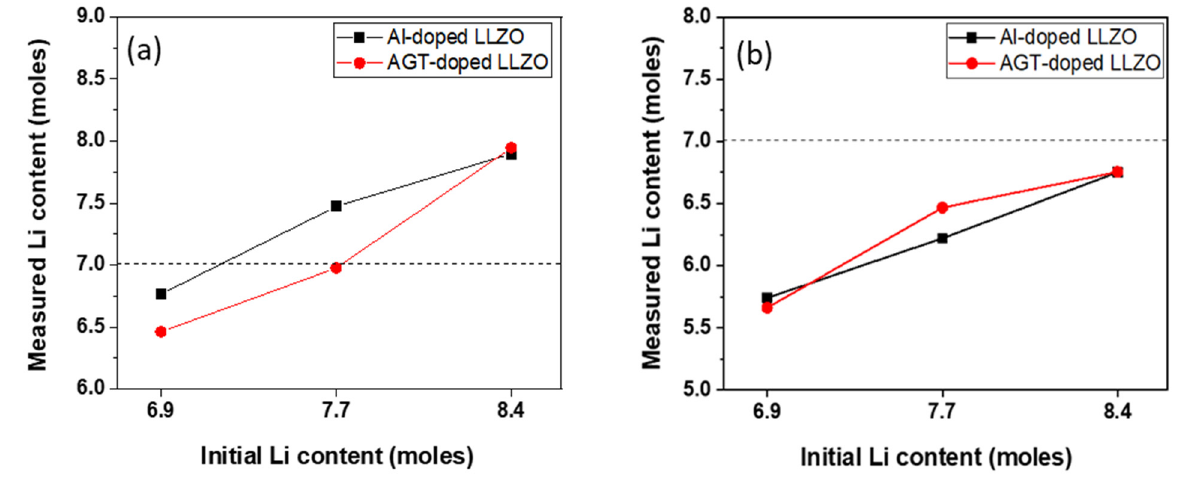
Figure 5. Change in Li-ion concentration of ( a ) calcined powders and ( b ) sintered pellets.